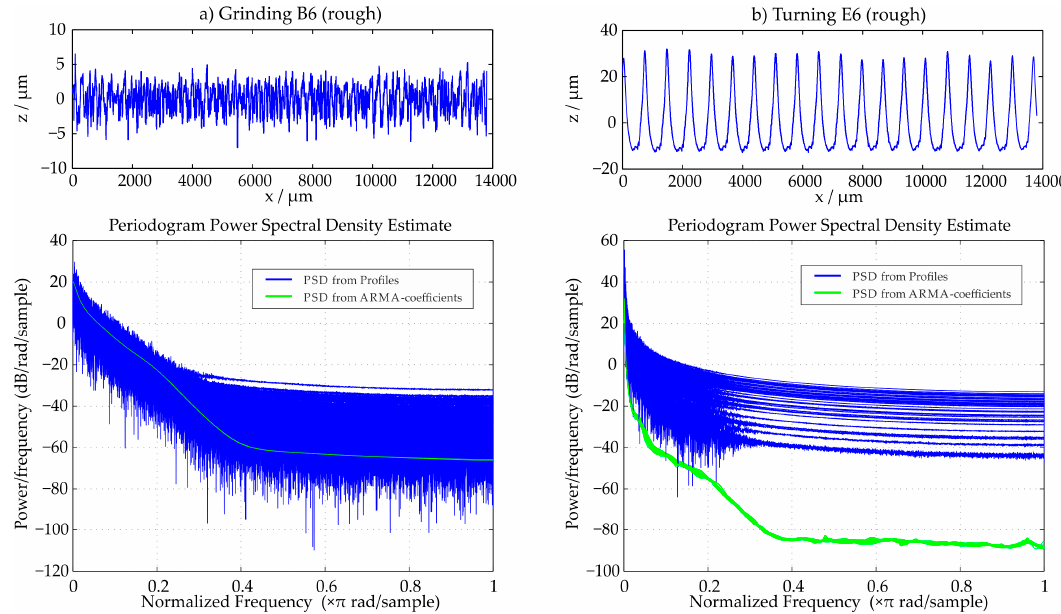
Figure 7. PSD comparison of stochastic (Grinding B6) and deterministic (Turning E6) profiles, the PSD-functions of all 50 evaluation areas are displayed.